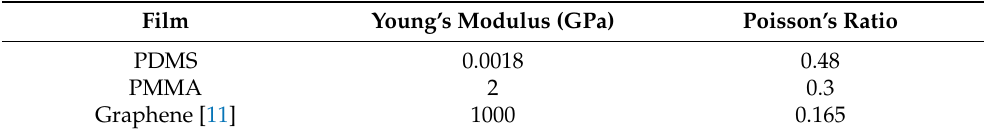
Table 1. Elastic properties of the three films. Film Young’s Modulus (GPa) Poisson’s Ratio PDMS